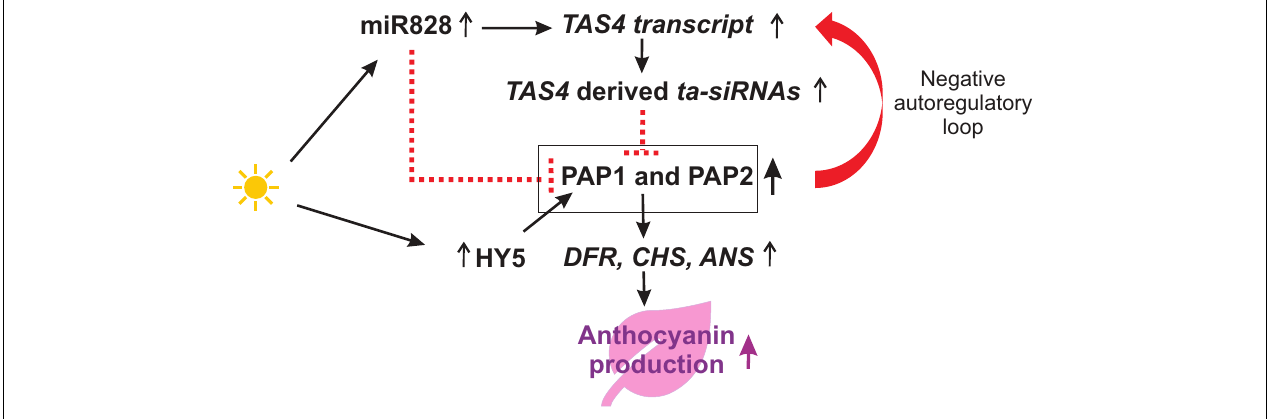
FIGURE 5 | Our current model on the regulation of anthocyanin biosynthesis in response to high light. Increased PRODUCTION OF ANTHOCYANIN PIGMENT 1 (PAP1) can bind to the PAP1 cis -elements of the TAS4 gene to induce TAS4 transcription. In response to high light, miR828 is upregulated and triggers the production of TAS4 derived ta-siRNAs. The ta-siRNAs can target PAP1 and PAP2 mRNAs and downregulate their transcript levels. Additionally, high light induced miR828 can also downregulate PAP1 transcripts. Furthermore, high light induces the transcription factor ELONGATED HYPOCOTYL 5 (HY5) that binds to the PAP1 promoter and activates PAP1 transcription that in turn provokes transcription of genes encoding enzymes involved in anthocyanin biosynthesis such as DIHYDROFLAVONOL 4-REDUCTASE (DFR), CHALCONE SYNTHASE (CHS) and ANTHOCYANIDIN SYNTHASE (ANS). After 2 days of high light treatment, the concomitant increase in the components of the proposed model were confirmed by our mRNA sequencing data which support previous findings (Hsieh et al., 2009; Luo et al., 2012; Yang et al., 2013). Black arrows symbolize positive regulation and red dashed lines indicate negative